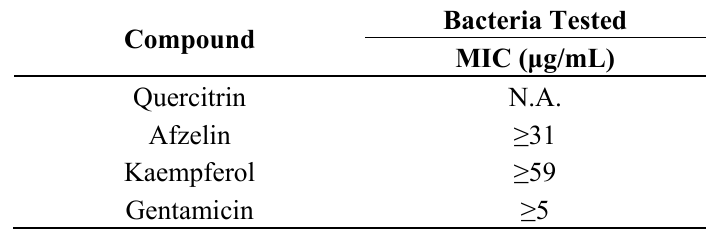
Table 3. Minimum inhibitory concentrations of quercitrin, afzelin and